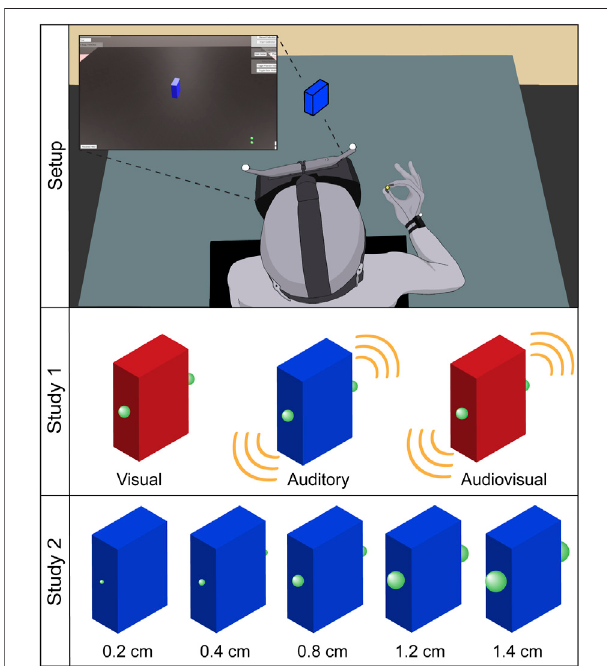
FIGURE 1 | Schematic illustration of the experimental setup and procedure. After wearing an HTC Vive TM head-mounted display (HMD), the participants sat on a chair in front of the experimental rig, with their thumb pressingastartswitch(indicatedinyellow).IREDmarkerswereattached to the participant ’ s wrist and the tips of the thumb and index fi nger. An auditory cue — a beep — signaled the participant to reach to grasp the object (small: 3.6 × 2.5 × 8 cm; medium: 5.4 × 2.5 × 8 cm; large: 7.2 × 2.5 × 8 cm), placed at three different distances relative to the switch (near: 24 cm; middle: 30 cm; far: 36 cm). An inset presents the fi rst person scene that appeared in the HMD. Translucent panels containing text in the visual scene were only visible to the experimenter. In Study 1, participants grasped the object with 0.8 cmcolliders,andvisual,auditory,oraudiovisualfeedbackwasprovidedto signalthattheobjecthasbeen grasped. InStudy2,audiovisualfeedbackwas providedtosignalthattheobjecthasbeengrasped,andparticipants grasped the object with 0.2, 0.4, 0.8, 1.2, and 1.4 cm colliders. In middle and bottom panels, the medium object is presented with the accurate scaling relationship between object dimensions and collider